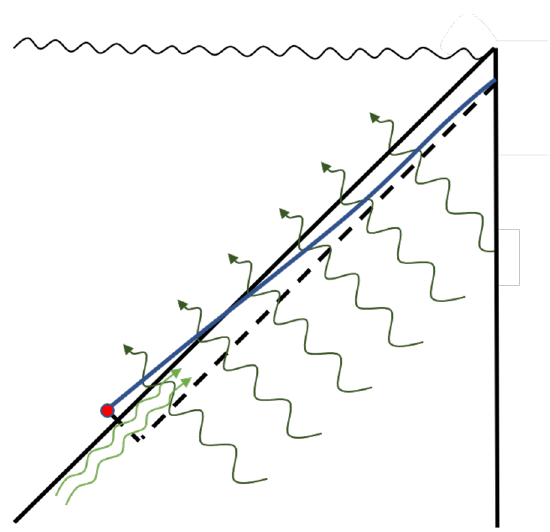
Figure 3. The bulk entropy of the region, shown in blue, between the Ryu-Takayanagi surface and the boundary can be decomposed into the entropy of the ingoing and outgoing modes. The ingoing modes are in the infalling vacuum, and the bulk region includes ingoing modes spread over approximately the scrambling time, which diverges in the semiclassical limit. This means that the gradient, in units of infalling time, of the entropy of the infalling modes tends to zero. In contrast, as the RT surface approaches the past lightcone of the boundary, there will be a negative logarithmic divergence in the (renormalised) entropy of the outgoing modes. This divergence should stabilise the location of the quantum extremal surface a small distance away from the outgoing